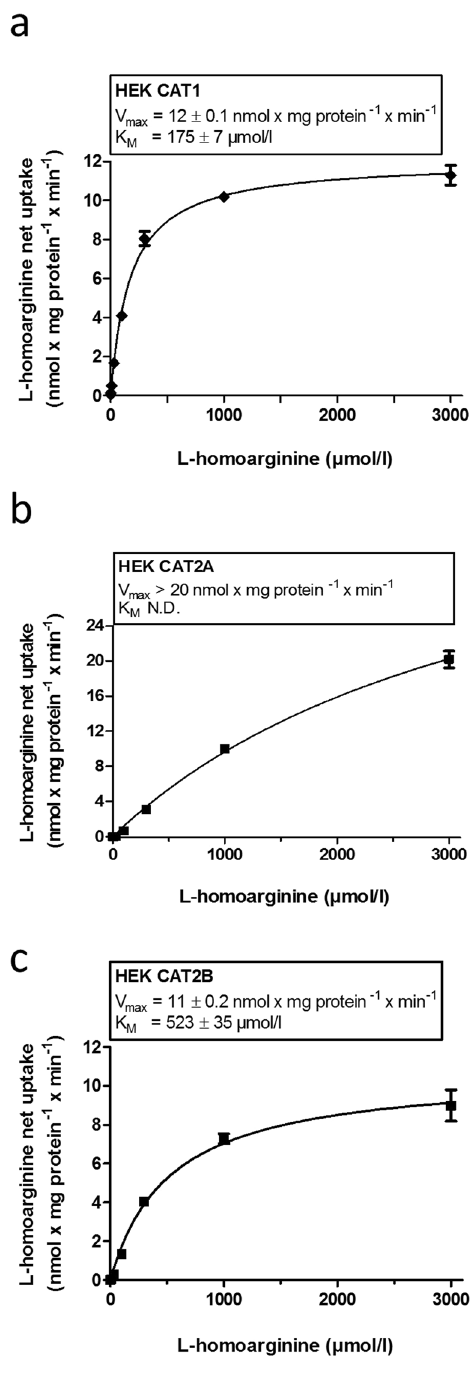
Figure 3. CAT1- ( a ), CAT2A - ( b ) or CAT2B-mediated ( c ) uptake of L-homoarginine dependent of the L-homoarginine concentration. Each data point is n =